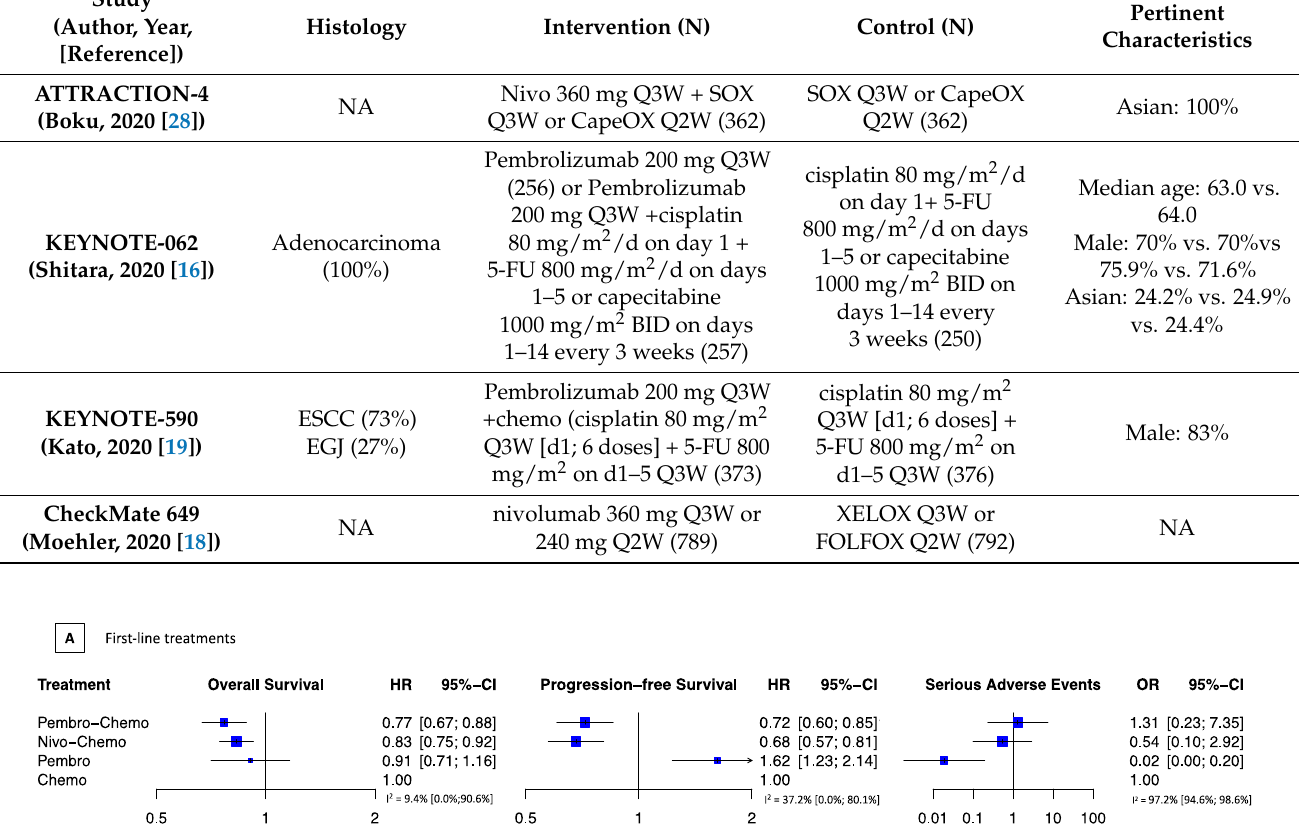
Table 1. Characteristics of Trials Included in the Network Meta-Analysis of first-line treatments.